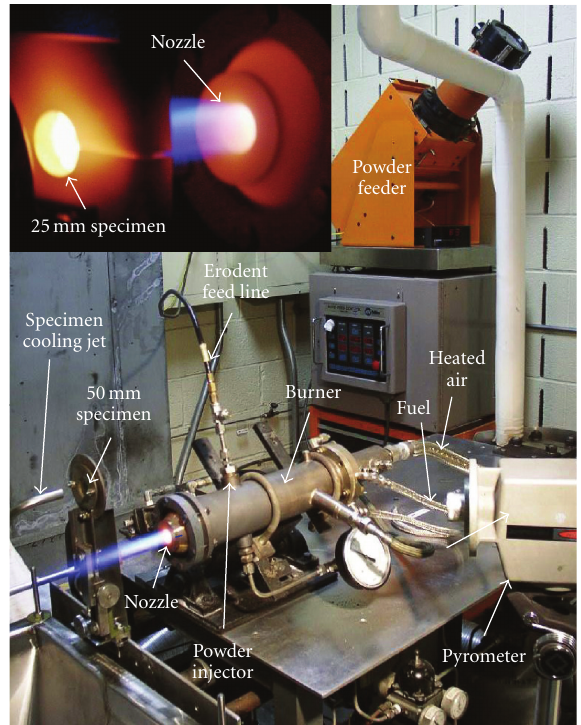
Figure 2: Photograph of an unducted burner-erosion rig during